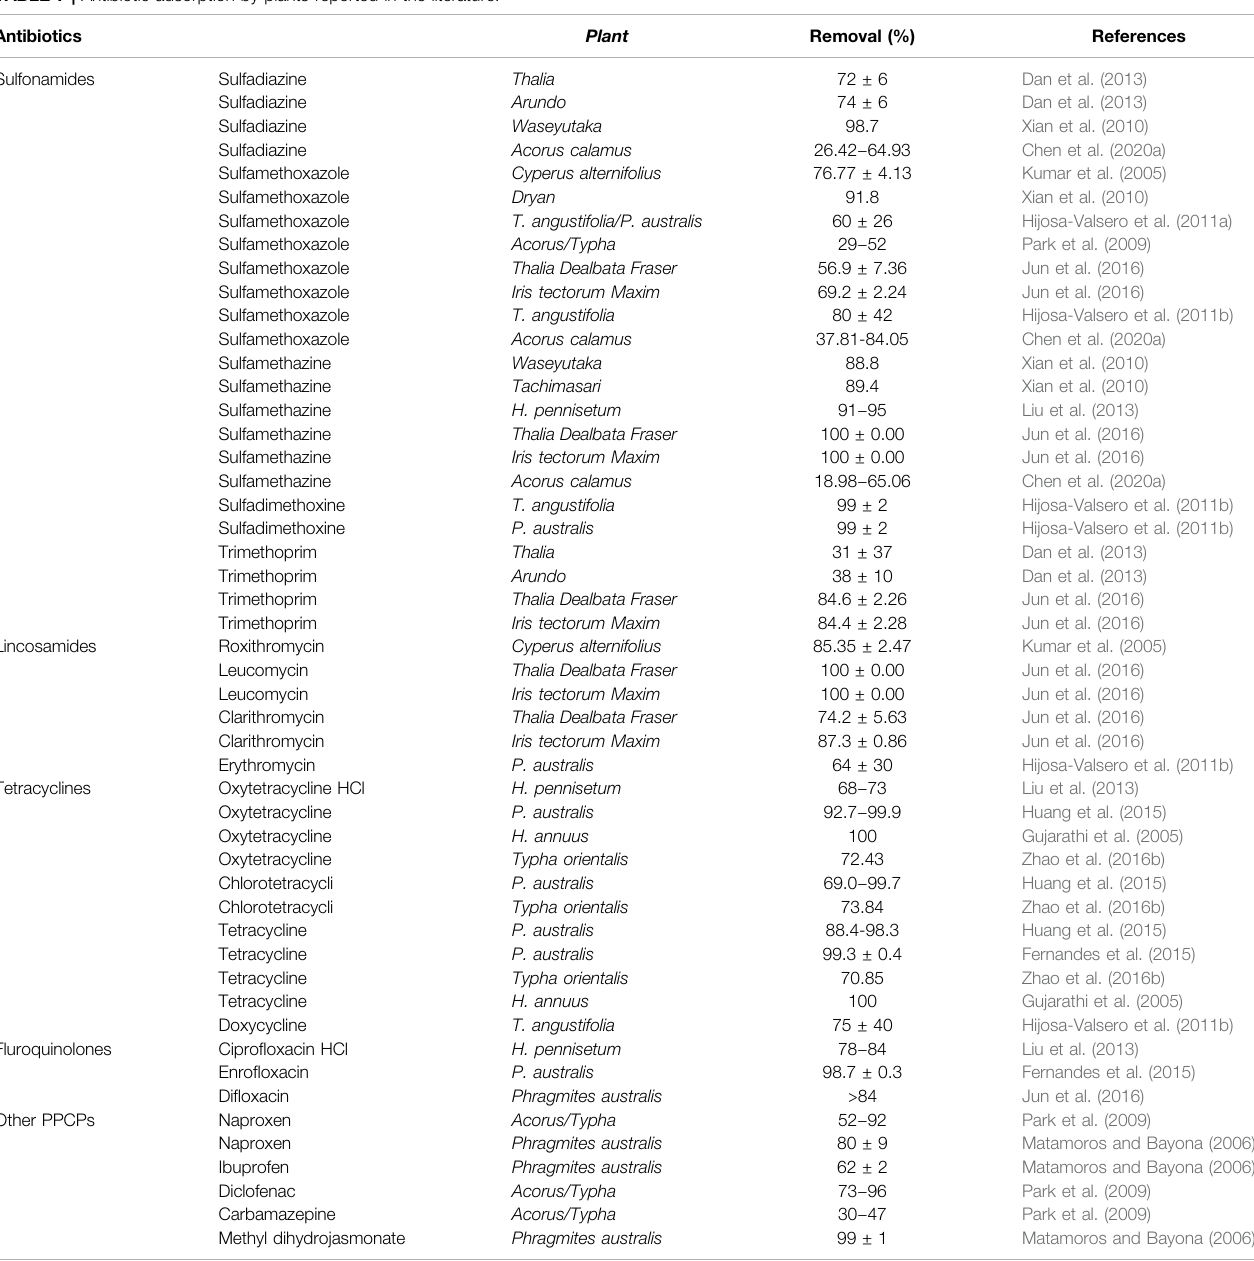
TABLE 7 | Antibiotic adsorption by plants reported in the literature.